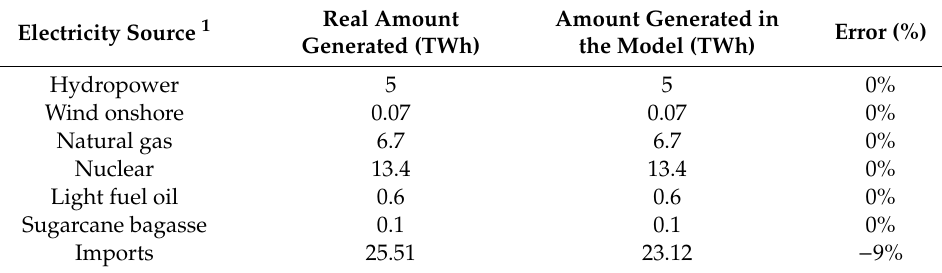
Table 6. Calibration results for base year